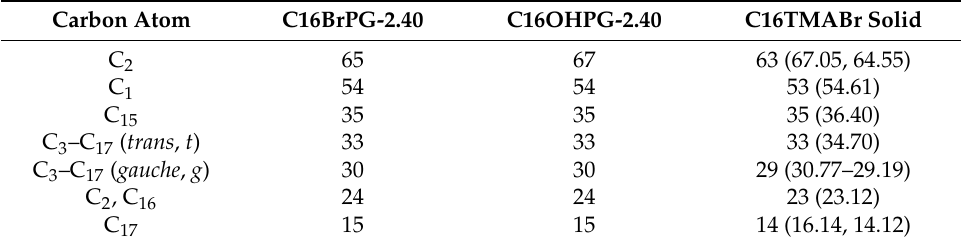
Table 4. 13 C chemical shift (ppm) of C16TMA in bulk and in OCs.